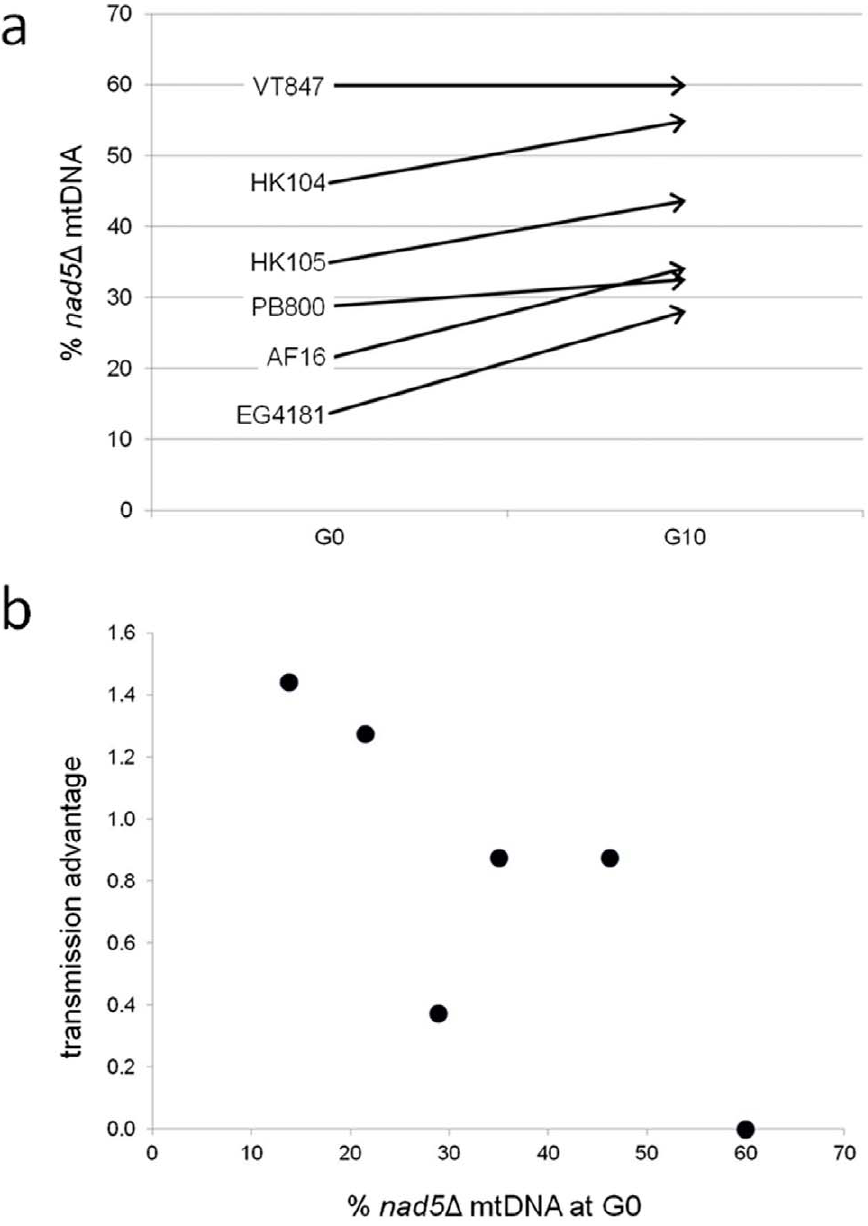
Figure 4. Transmission bias of nad5 D mtDNA. (a) For each of the six Clade I and II C. briggsae strains analyzed, the change in average estimated percent nad5 D mtDNA between G0 and G10 is shown. (b) The per-generation percent transmission advantage is shown as a function of estimated % nad5 D mtDNA at G0.